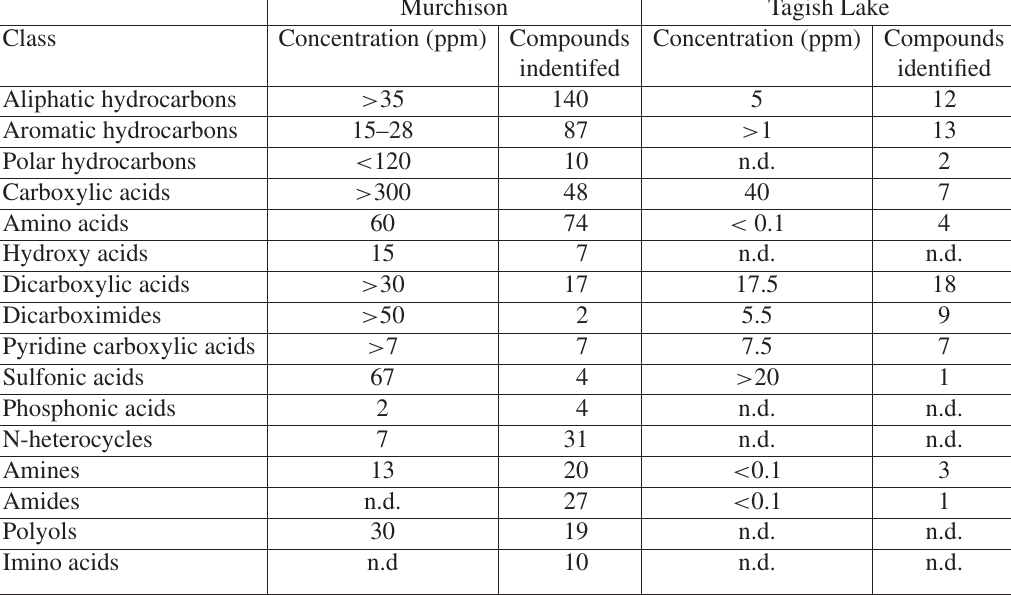
Table 1. Soluble organic compounds detected in Murchison and Tagish Lake, from